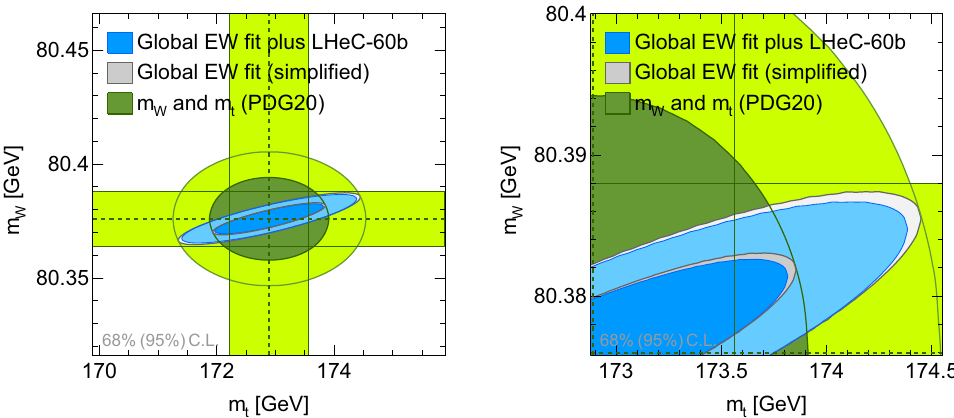
Fig. 17 Left: Expected uncertainties from a simplified global EW fit including LHeC-60b inclusive NC/CC DIS data. The results are com- pared with expected uncertainties from the simplified global EW fit